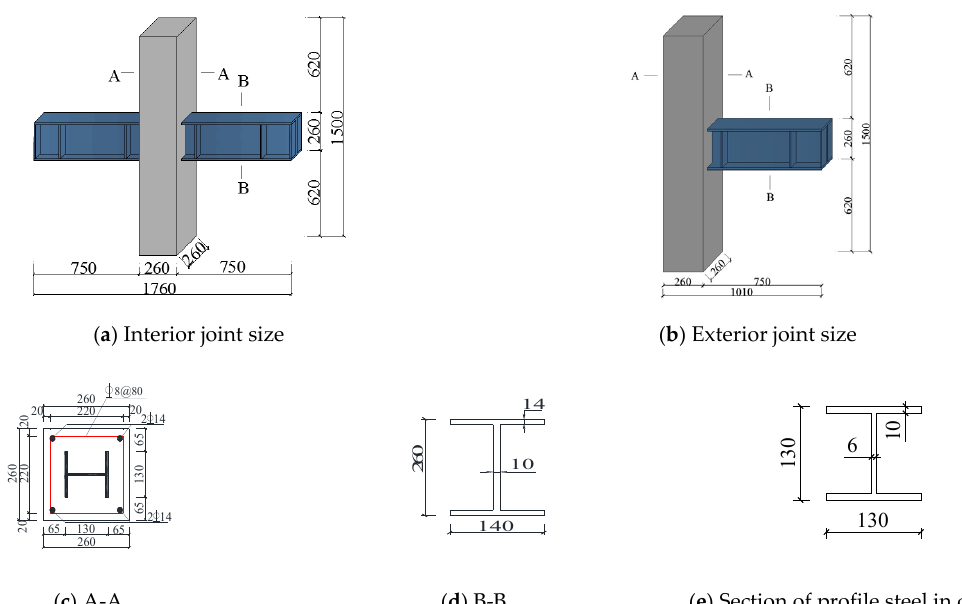
Figure 1. Size and distributed steel of specimens (mm).